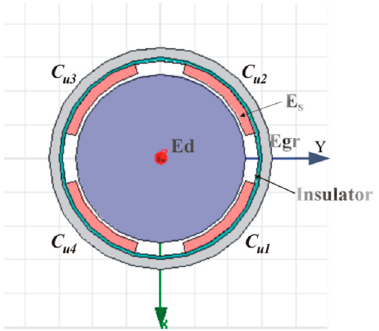
Figure 10. The cross-sectional view of previously developed CCS (2-DOF). The thickness of its sensing electrode Es is 3 mm. Table 1. Simulation model parameters of T-type CS.